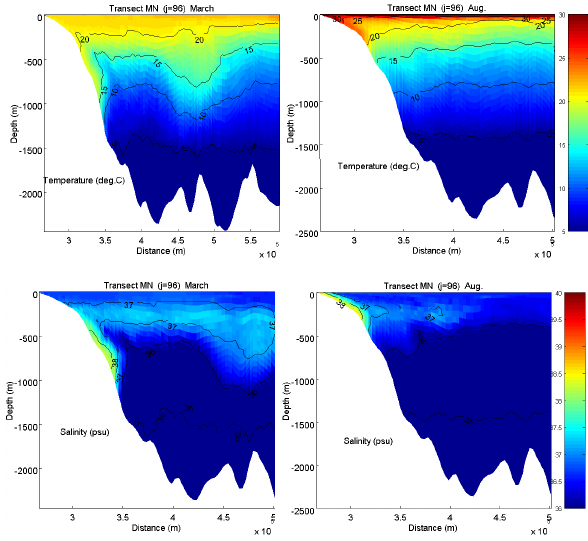
Fig. 12. Cross-section of the mean velocity components along the IJ path shown in Fig. 5, obtained from model simulation during March (left) and August (right).